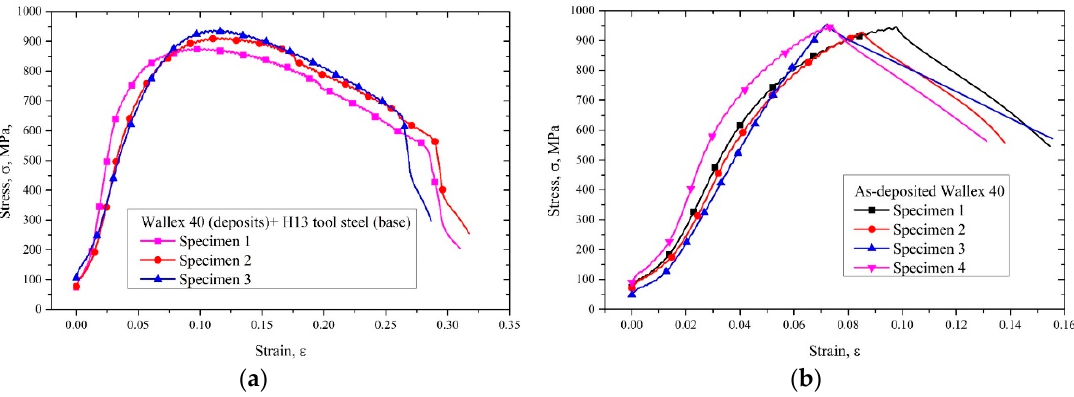
Figure 18. ( a ) Tensile stress–strain curves of Wallex 40 + H13 tool steel specimens; ( b ) tensile stress–strain curves of Wallex 40 specimens.